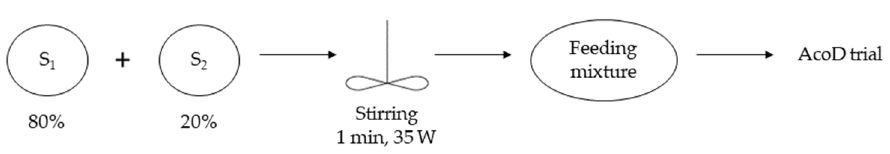
Figure 3. Feed mixture preparation for AcoD trials. Experimental conditions: mixing at 50 rpm, 35 W, for 1 min at room temperature.